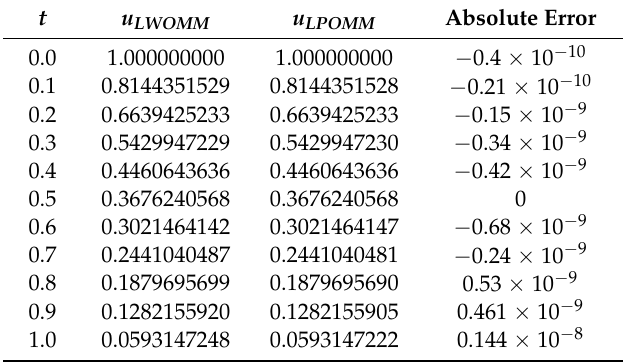
Table 7. Numerical solutions of u ( t ) when α = 0.99 for Example 4.